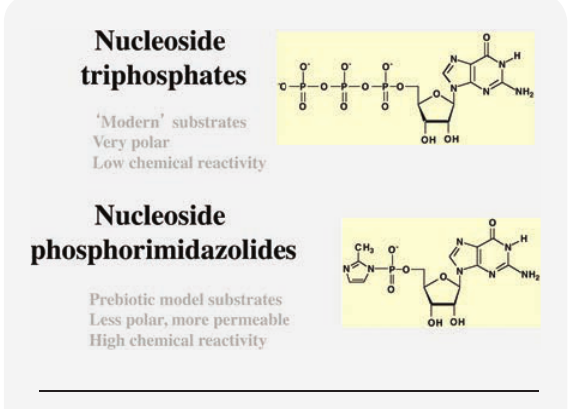
Figure 8. Modern vs. prebiotic means of nucleotide activation. Mod- ern cells use nucleoside triphosphates (NTPs, top) for the enzymatic synthesis of RNA and DNA. Primitive cells must have used more reactive and less polar substrates, such as the nucleoside phospho- rimidazolides (bottom), for RNA replication.